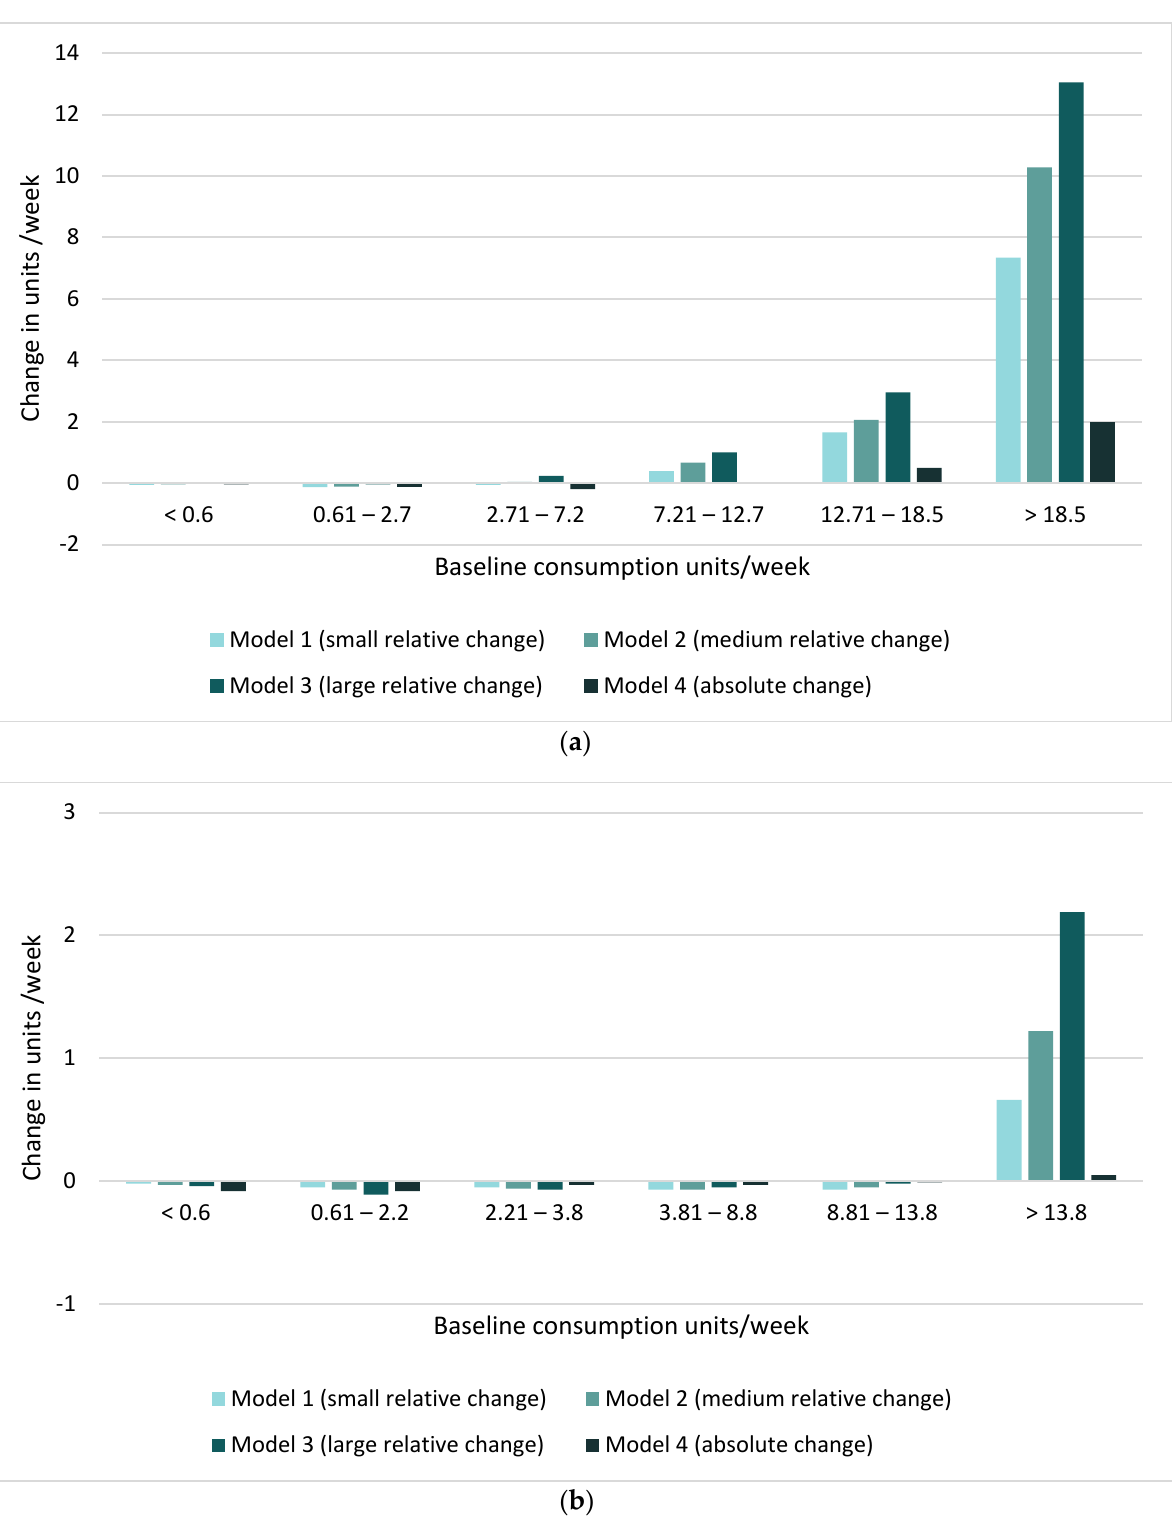
Figure 2. ( a ) Estimated change in the volume of consumption during the pandemic by baseline consumption level and four models for estimating change—ESAC survey. ( b ) Estimated change in volume of consumption during the pandemic by baseline consumption level and four models for estimating change—Opinion survey. Note 1: baseline consumption level categories correspond to intervals between the percentiles presented in Table 2, respectively.